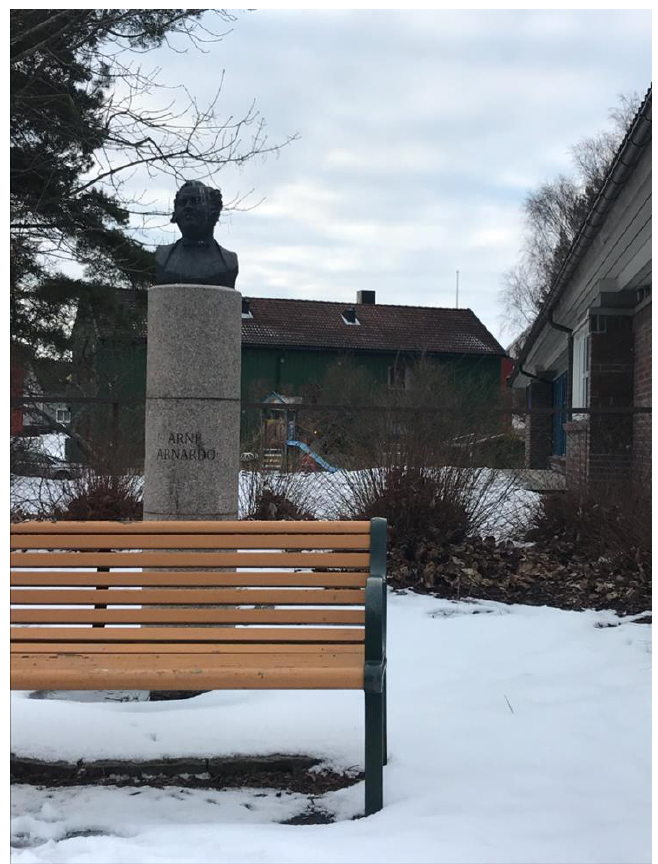
Figure 5. Cohesion (photograph taken by Parent